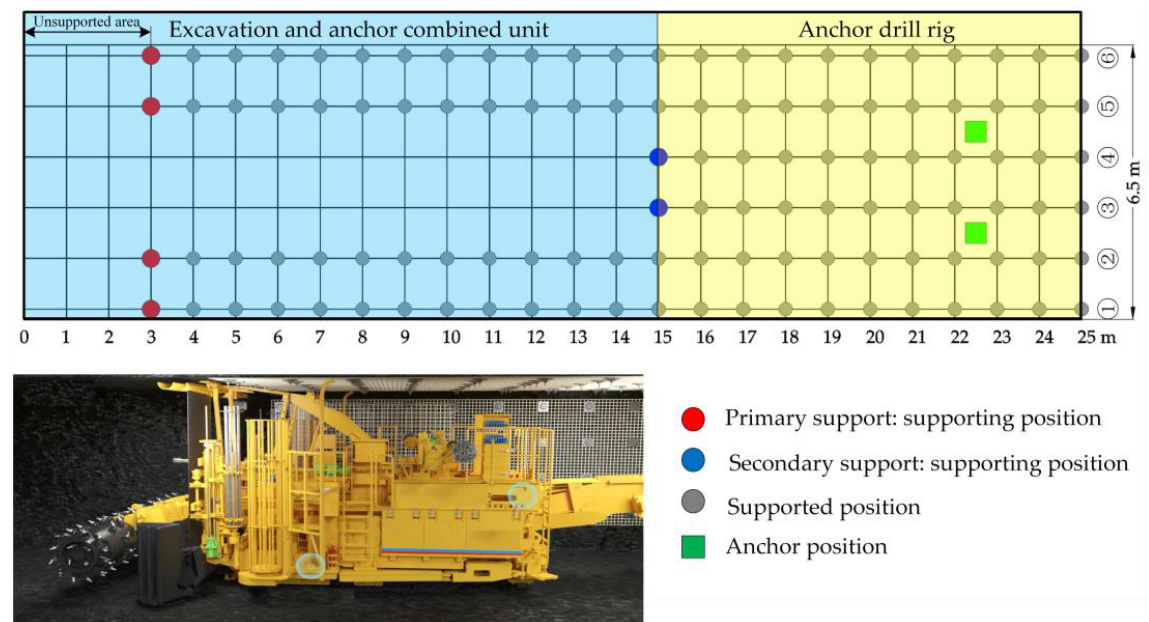
Figure 14. The 122,110 auxiliary transport roadway heading and support diagram.